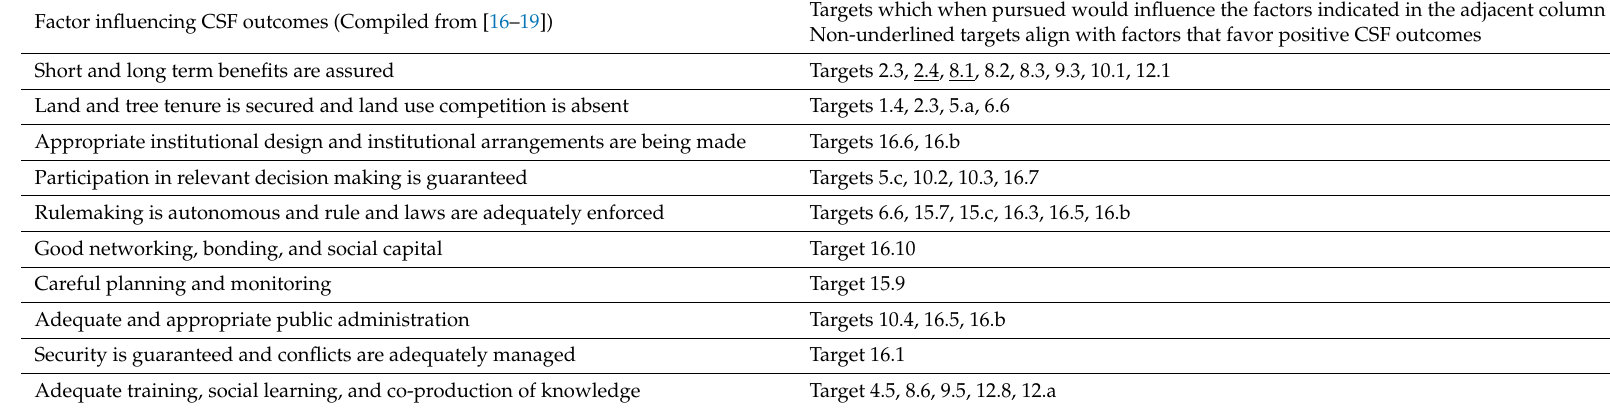
Table 2. Factors facilitating successful CSF outcomes and their linkages with SDGs and